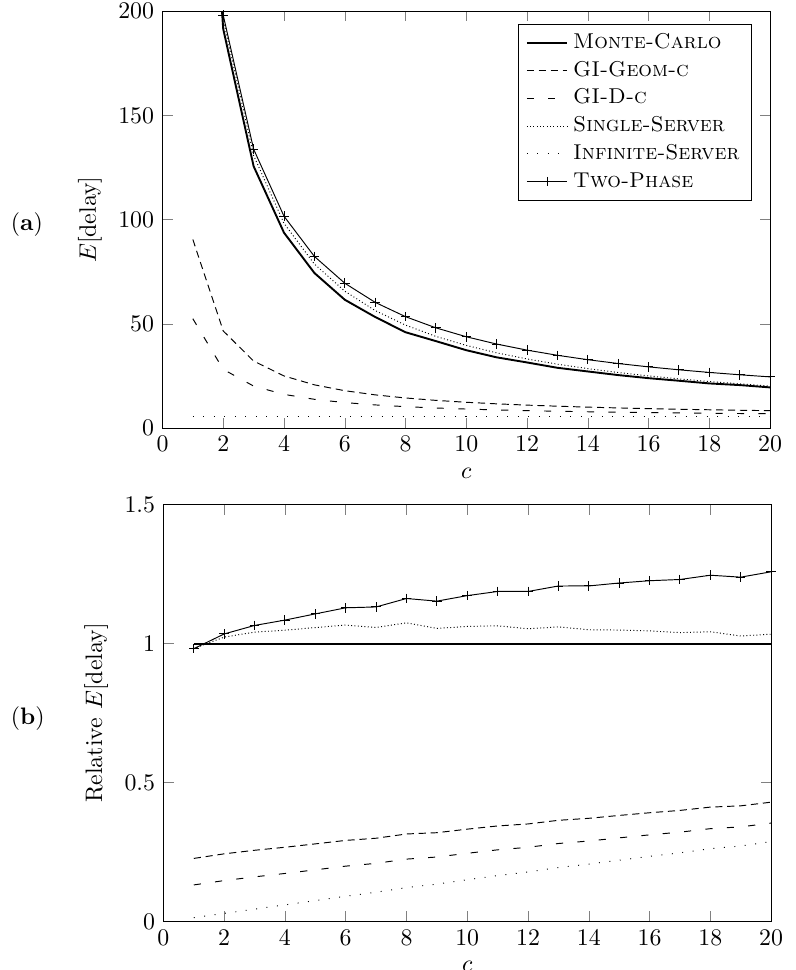
Figure 3. Mean customer delay versus the number of servers c for a system with Poisson arrivals, bursty service demands, and negative-binomial service capacities with 5 phases and mean µ = 10, with variable mean arrival rate λ such that the load ρ = 0.95, as estimated by various approximations, ( a ) in absolute value; and ( b ) relative to the M ONTE -C ARLO